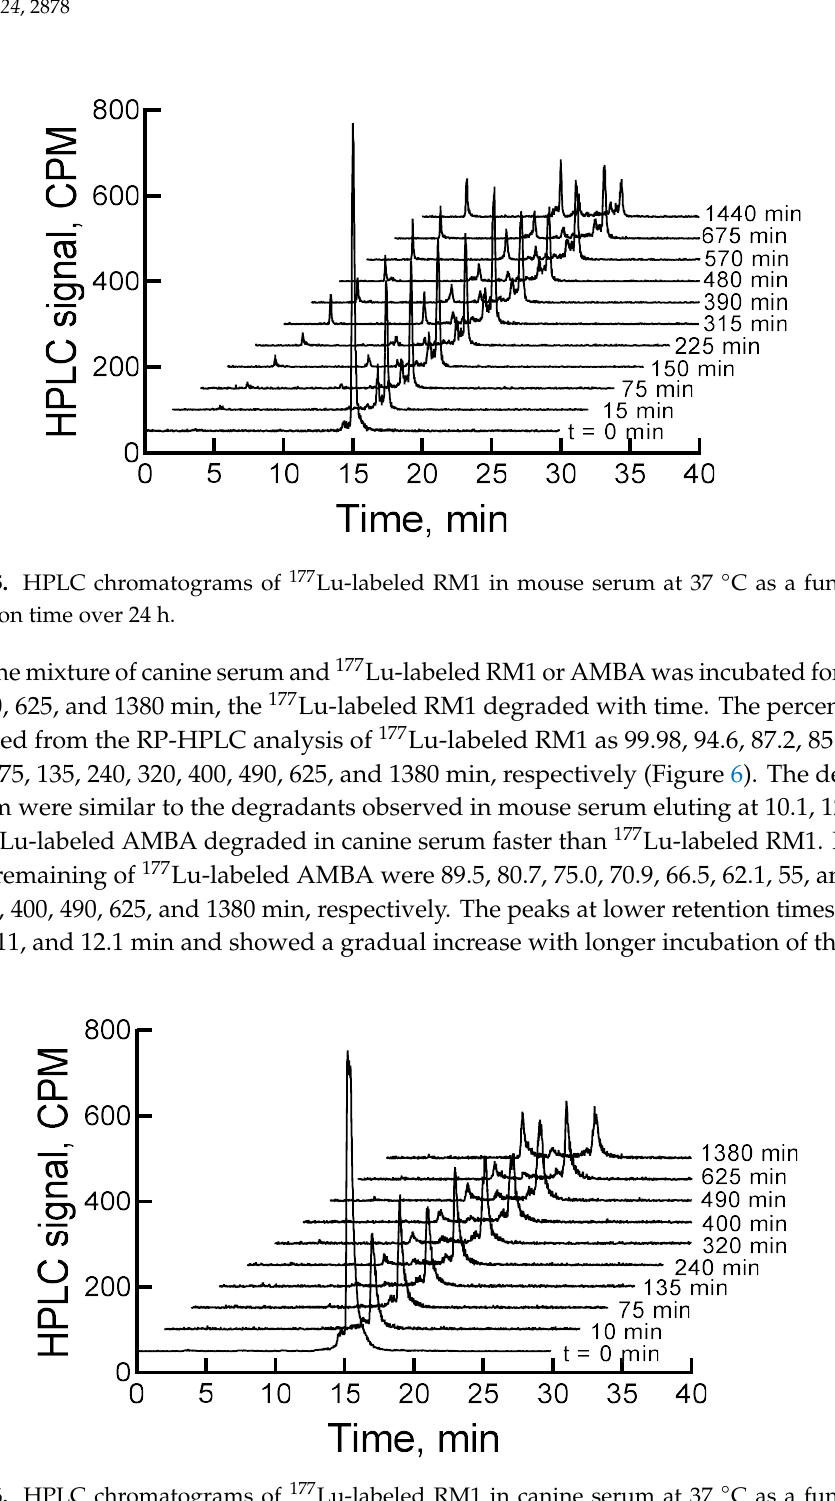
Figure 6. HPLC chromatograms of 177 Lu-labeled RM1 in canine serum at 37 °C as a function of incubation time over 24 h.